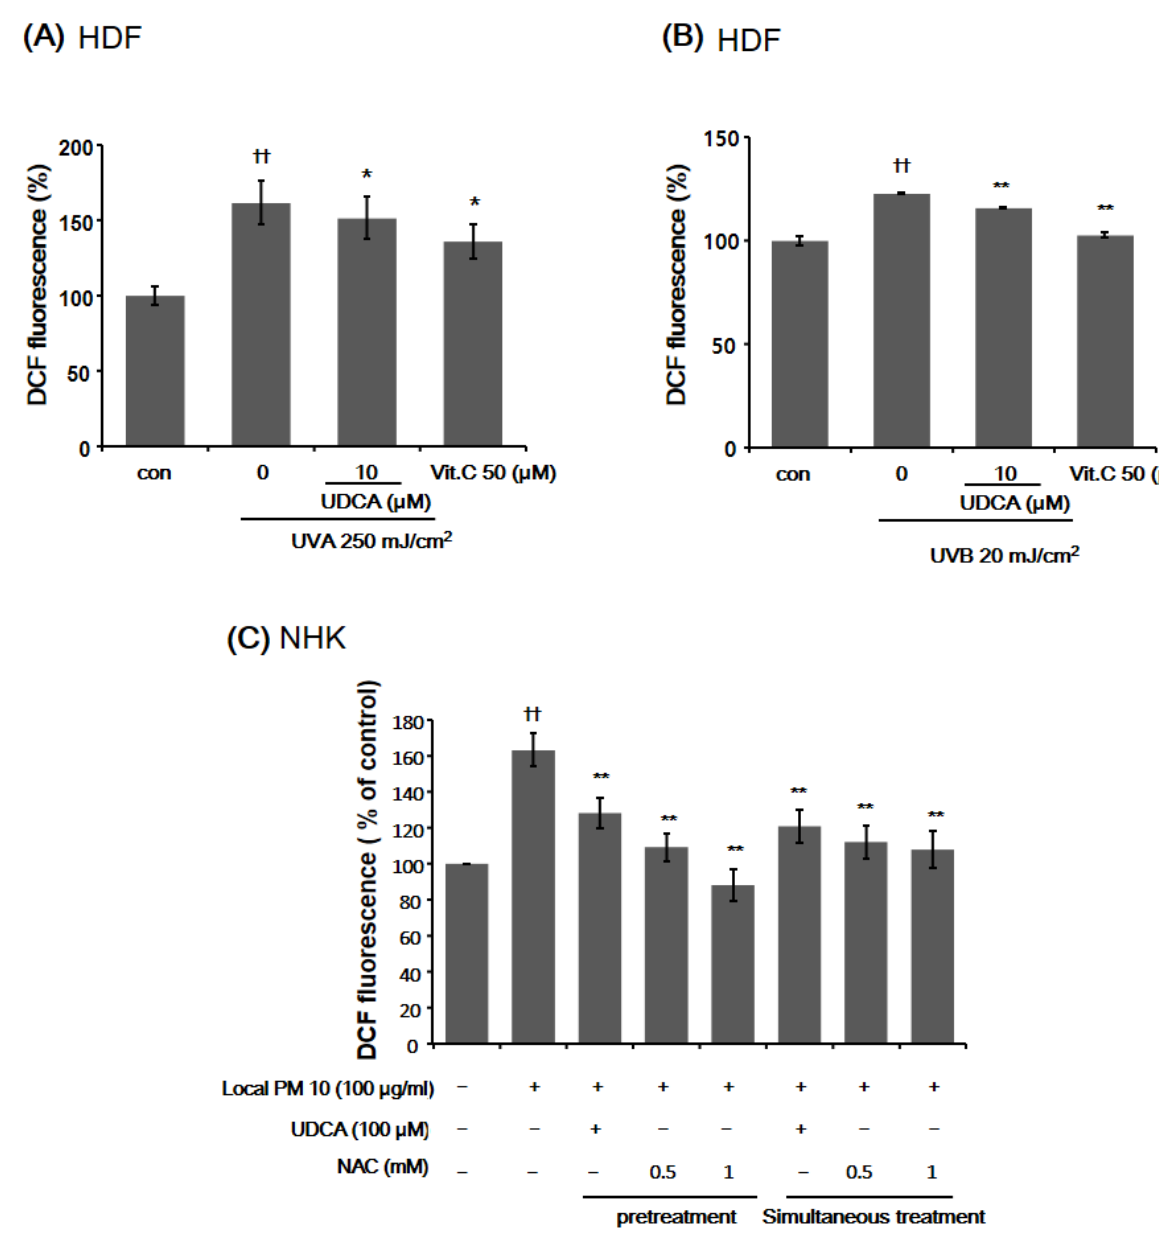
Figure 1. The effect of ursodeoxycholic acid (UDCA) on intracellular oxidative stress. ( A ) Exposure of human dermal fibroblasts (HDFs) to 250 mJ/cm 2 of UVA resulted in a significant increase in intracellular oxidative stress, which was attenuated by treatment with 10 µ M UDCA. ( B ) Similarly, exposure of HDFs to 20 mJ/cm 2 of UVB resulted in a significant increase in intracellular oxidative stress, which was effectively mitigated by treatment with 10 µ M UDCA. Treatment with 50 µ M of vitamin C was used as a positive control. ( C ) The effect of UDCA treatment on the intracellular oxidative stress of normal human keratinocytes following exposure to particular matter (PM). Three hours after treatment with 100 µ g/mL of local PM10, NHKs were either pretreated or treated simultaneously with UDCA. Both modes of UDCA treatment resulted in a significant reduction of oxidative stress, measured by DCF fluorescence. Treatment with N-acetylcysteine (NAC) was used as a positive control. * p < 0.05 and ** p < 0.01 compared with UV-exposed or PM-treated control, †† p < 0.01 compared to control (con).